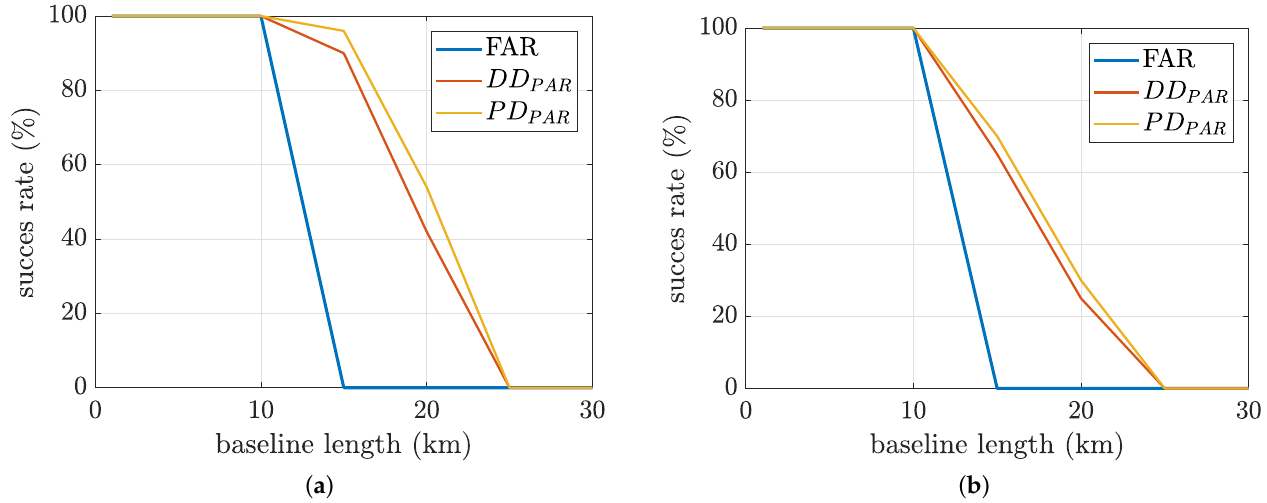
Figure 6. Comparison with different ambiguity resolution schemes for one GNSS constellation only. ( a ) GPS (L1 + L2) experimental success rate. ( b ) Galileo (E1 + E5a) experimental success rate.